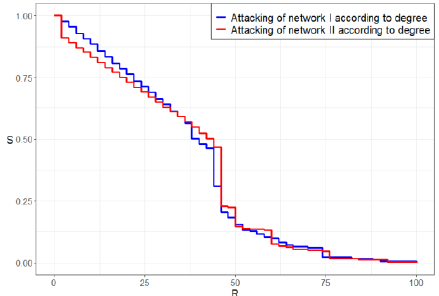
Fig. 8. The relative results of maximum connected subgraph (attacking according to in-degree).